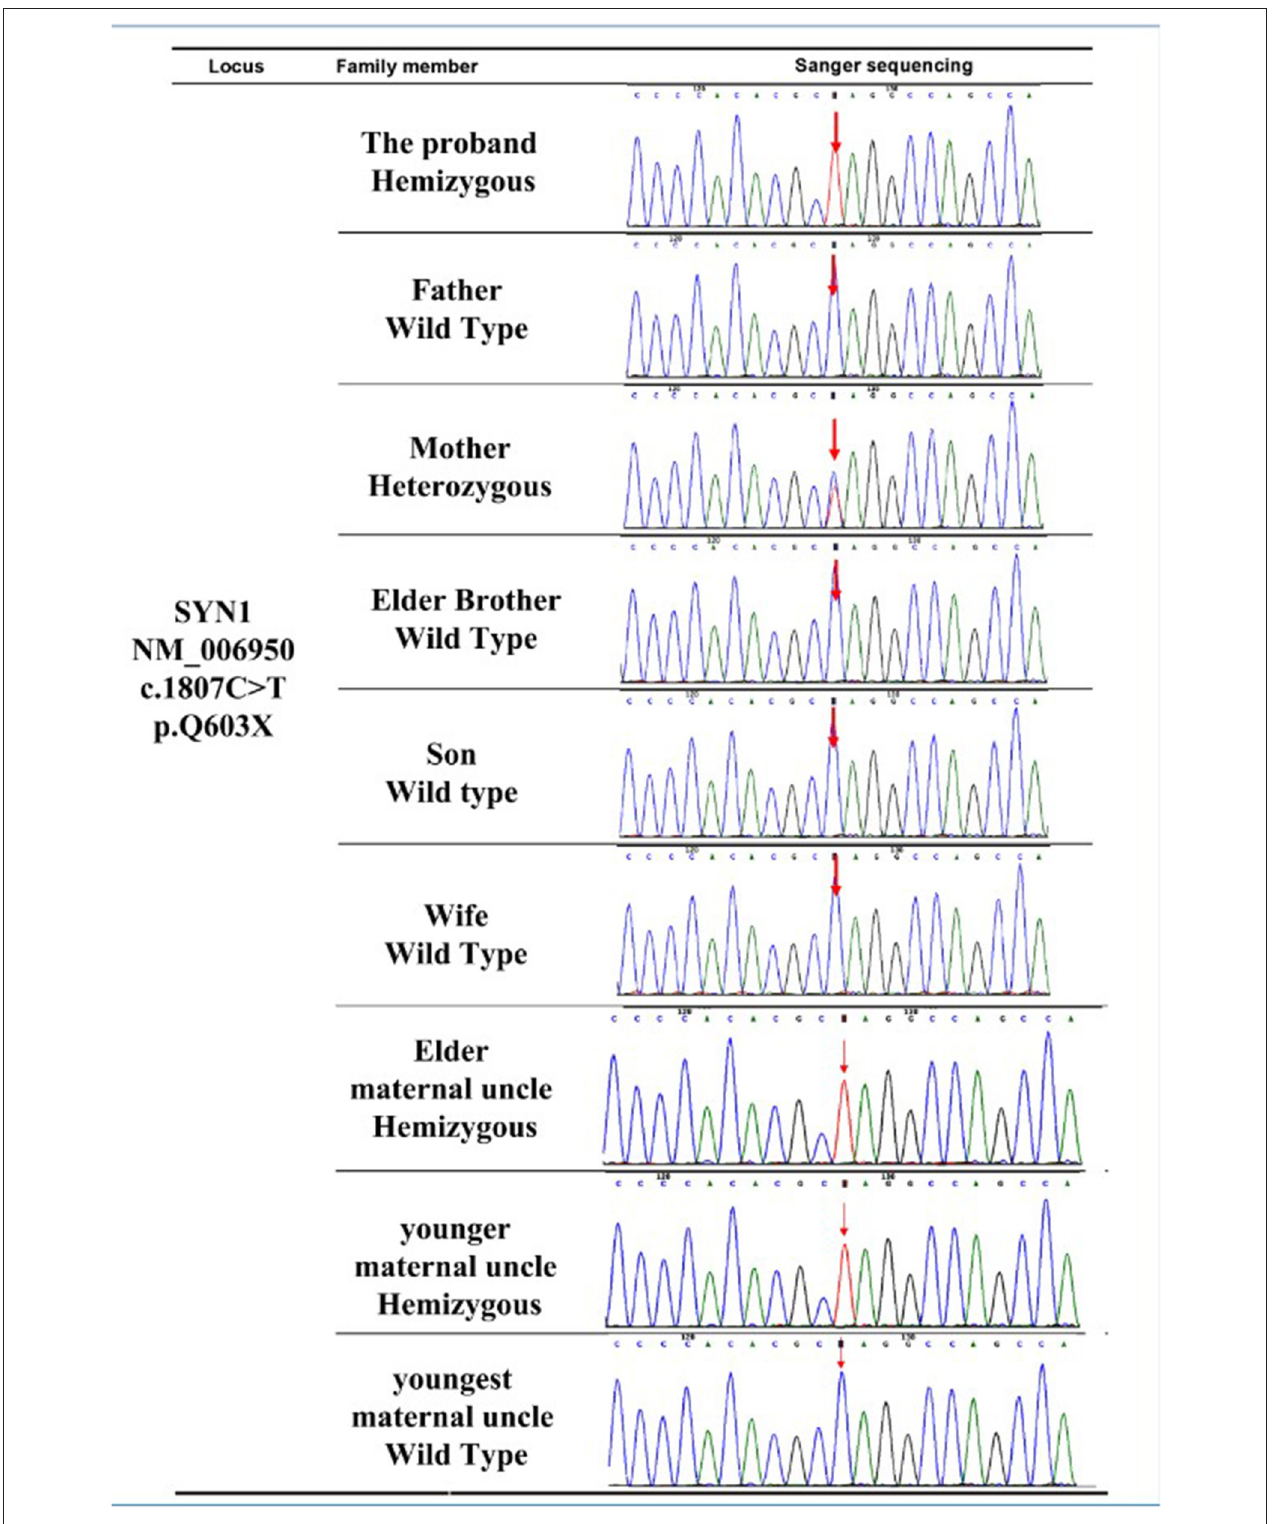
FIGURE 2 | Multiple sequence alignment analysis of the SYN1 mutation site. The mutant site (amino acid 603) is denoted by the red arrow.